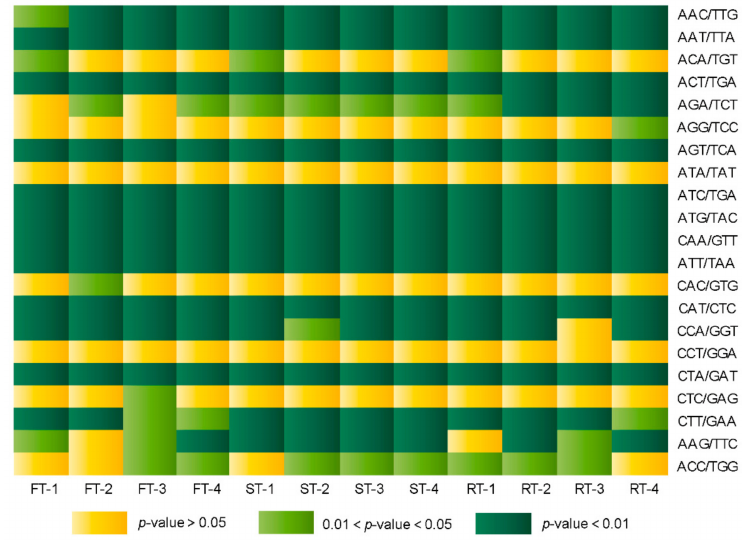
Figure 2. Chi-square test of complementary TNRs.